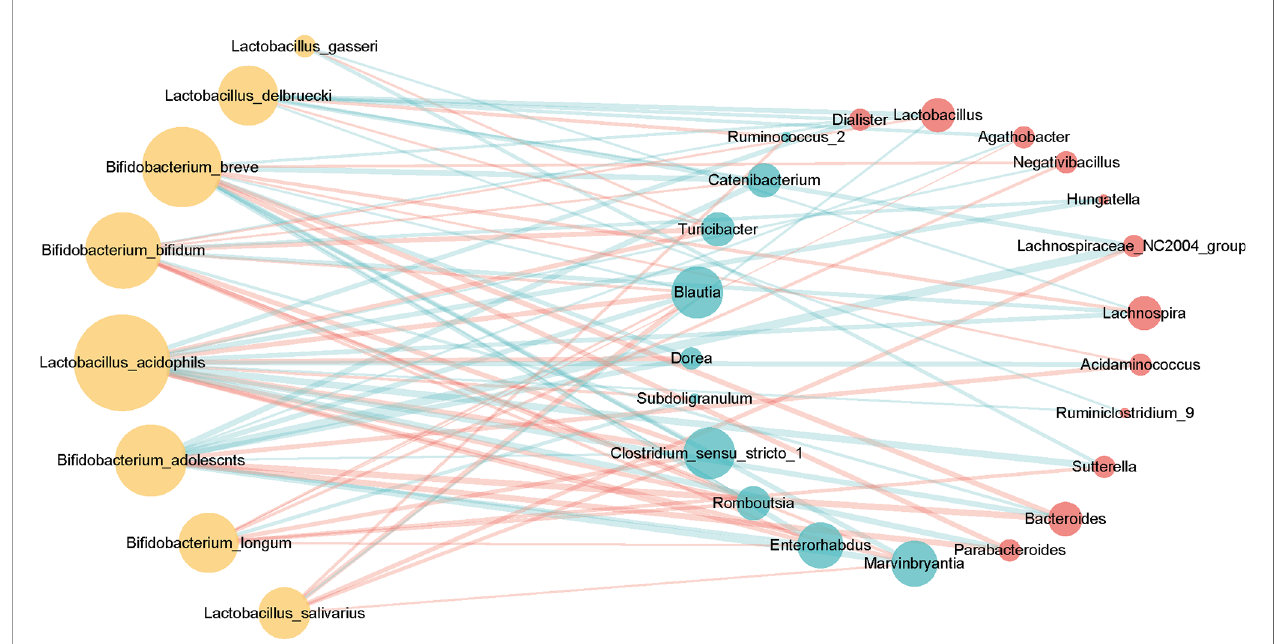
FIGURE 5 | Associations between T2DM-enriched or depleted genera and probiotics. Differentially enriched 24 genera ( q -value <0.05, FDR-controlled Wilcoxon rank-sum test, Table 2 ) were analyzed for associations with probiotics. Twenty-two of the 24 genera with signi fi cant correlation [P-value <0.05, abs(r-value)>0.1] were selected for the visualization. T2DM-enriched genera are represented by red circles, and control-enriched genera are represented by cyan circles. The size of each circle indicates connectivity. Green lines indicate positive association, and red lines — negative